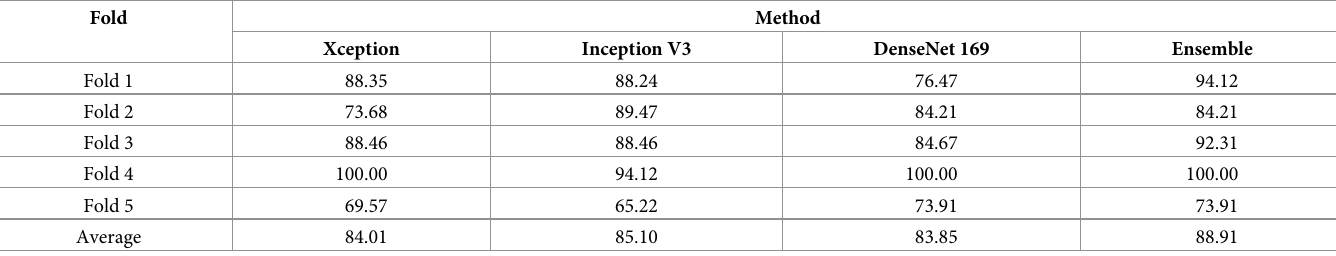
Table 3. Fold wise precision scores concerning the base models and the ensemble method. All scores are reported in